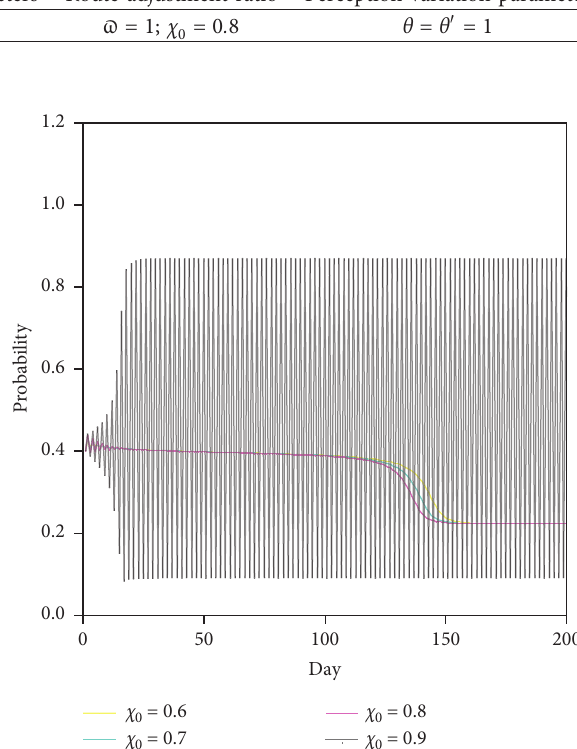
Figure 3: Evolution of link 1 chosen probabilities under different